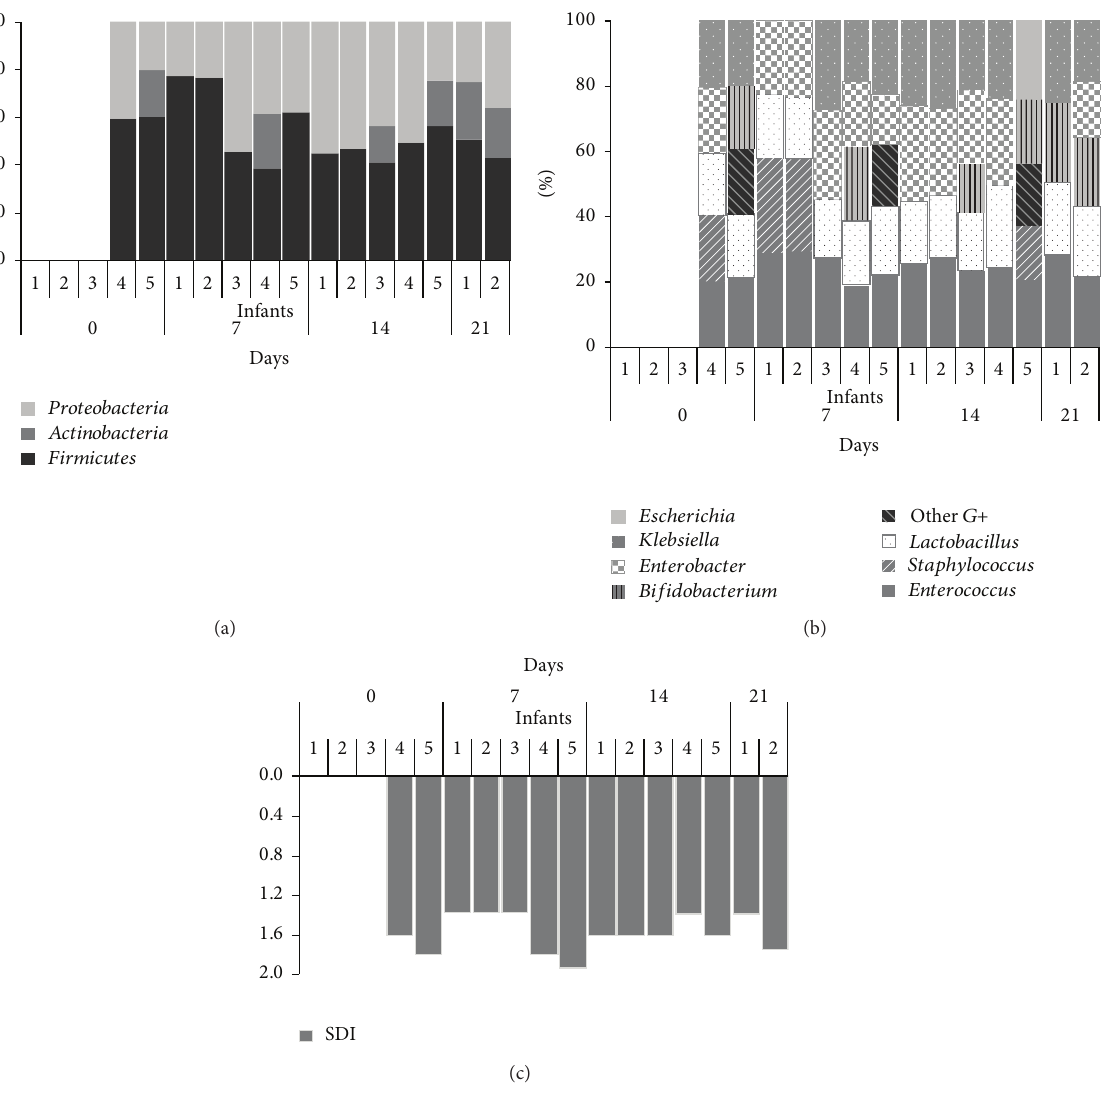
Figure 1: Phyla (a), genera (b), and bacterial diversity assessment bythe SDI (c) of the microbiota of the meconium and fecal samples analyzed in this study. The relative contributions of the phyla and genera to the microbiota of the infant’s gut and the SDI values were labeled per case and sampling